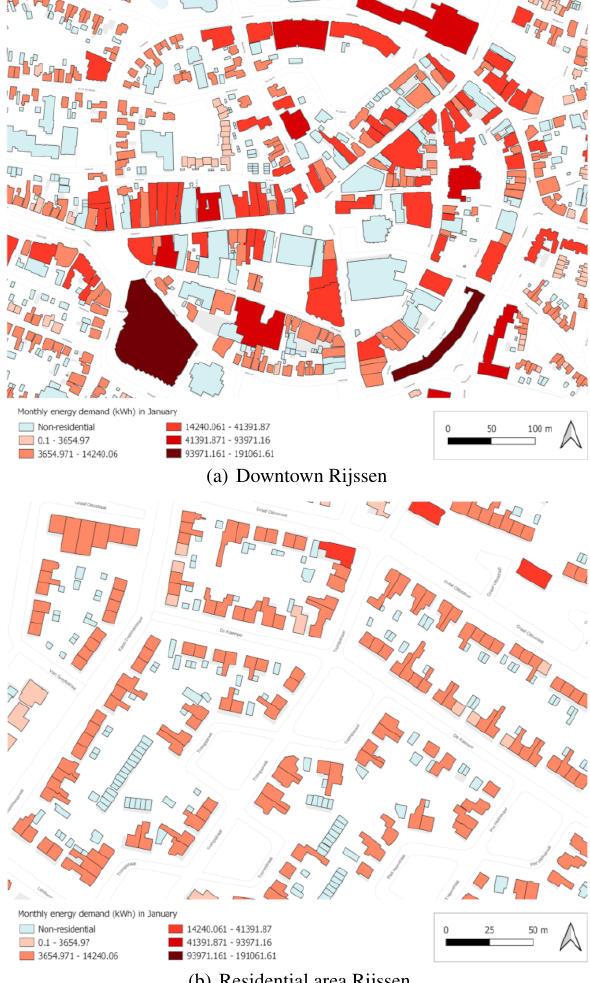
Figure 15. Sample results of the Energy demand (kWh) in Rijssen-Holten (Tufan,